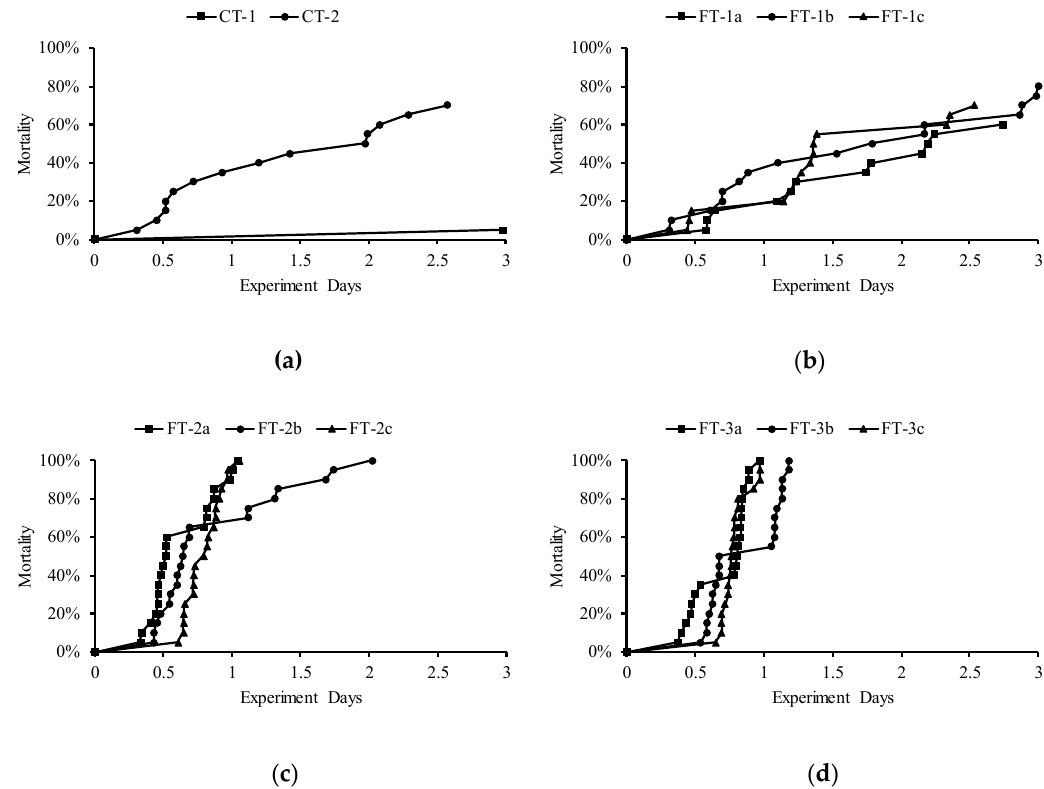
Figure 6. The mortality of fish in each case, ( a – d ) represent the mortality in CT, FT-1(a–c), FT-2(a–c), and FT-3(a–c), respectively.